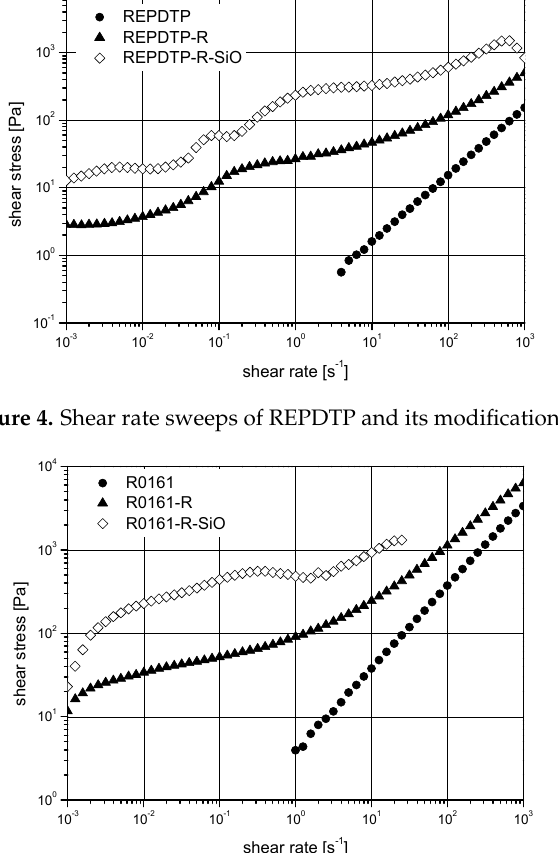
Figure 5 . Shear rate sweeps of R0161 and its modifications. Figure 5. Shear rate sweeps of R0161 and its